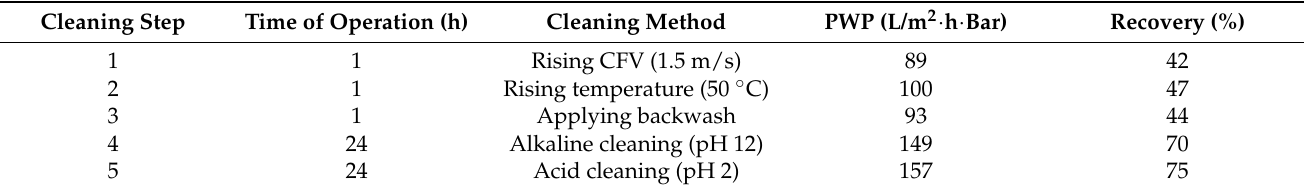
Table 5. Recovery of pure-water permeability (PWP) after experiment 2 by the aid of several physical and chemical cleaning methods (PWP measured 211 L/m 2 · h · bar and 90 L/m 2 · h · bar before and after experiment 2, respectively; recovery before cleaning was 43%; cleaning steps 1 to 5 were performed